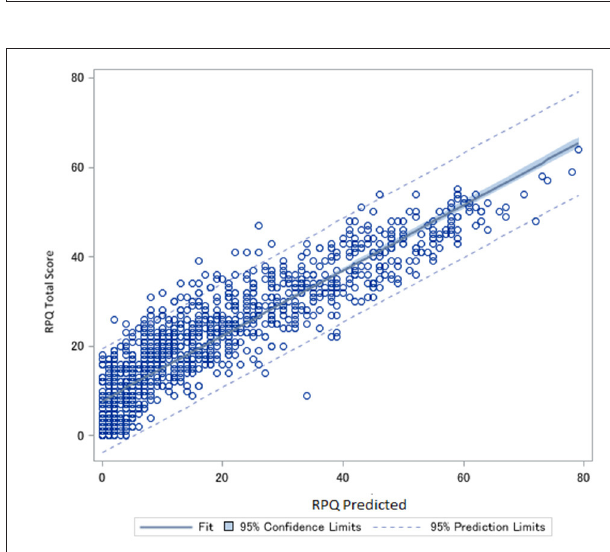
FIGURE 4 | Predicted Rivermead post-concussion Symptoms Questionnaire (RPQ) scores plotted against actual RPQ scores.